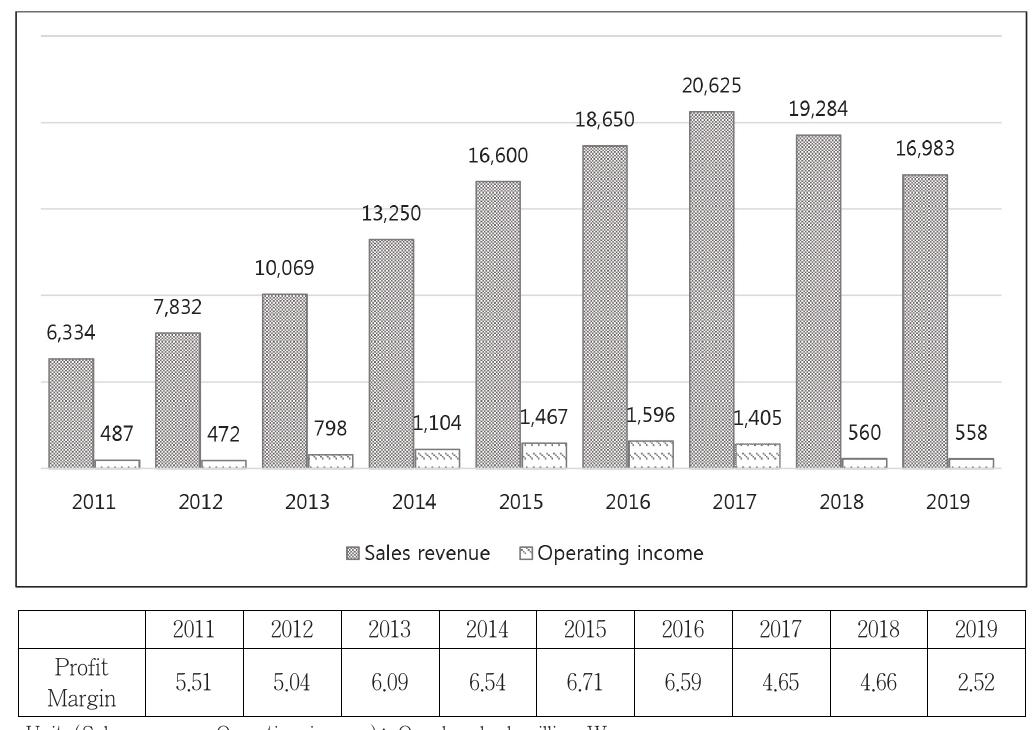
<Figure 1> HANSSEM's Annual Sales Revenue and Operating